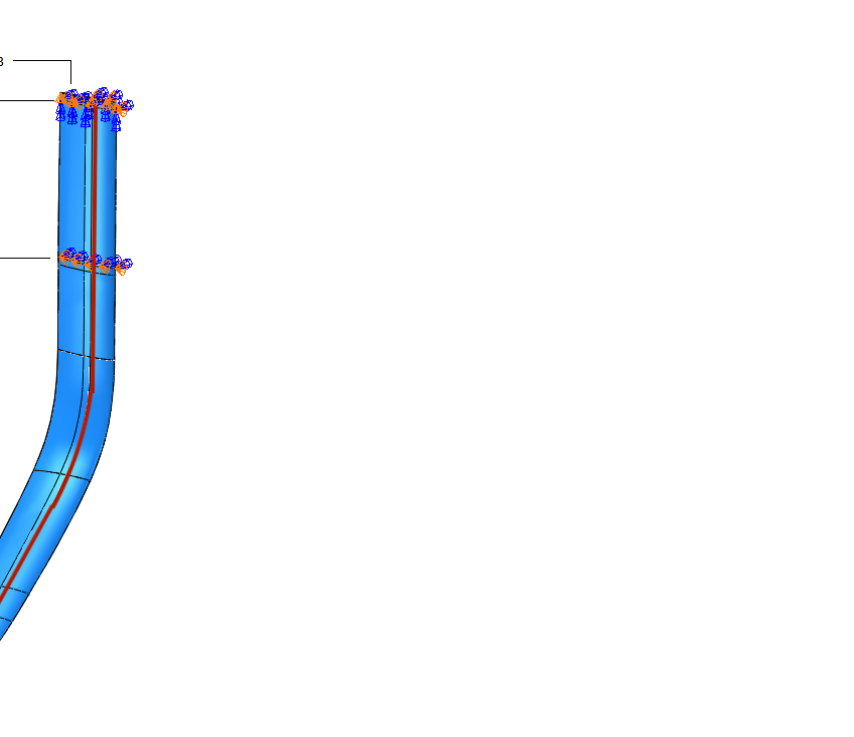
Figure 15. Boundary conditions at the root and 500 mm below the root and example location of applied F X and F Z forces. In red the location of the probed line from which the displacement and stresses are extracted.